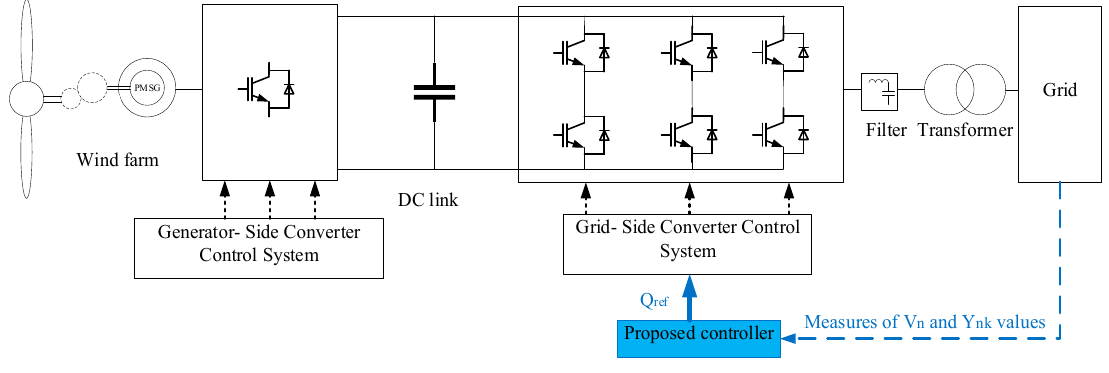
Figure 2. Control system structure.